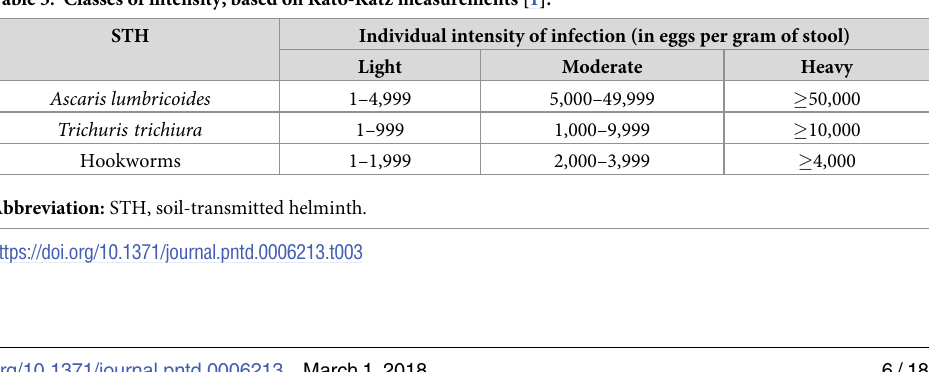
Fig 2. Diagnostic use-cases, described by program decision algorithm. Dashed box indicates a decision not described under current WHO guidelines for controlling STH morbidity but that may be important for a program aiming to eliminate transmission of STH. Dx, diagnostic; KK, Kato-Katz; MDA, mass drug administration; SAC, school-aged children; STH, soil-transmitted helminth.